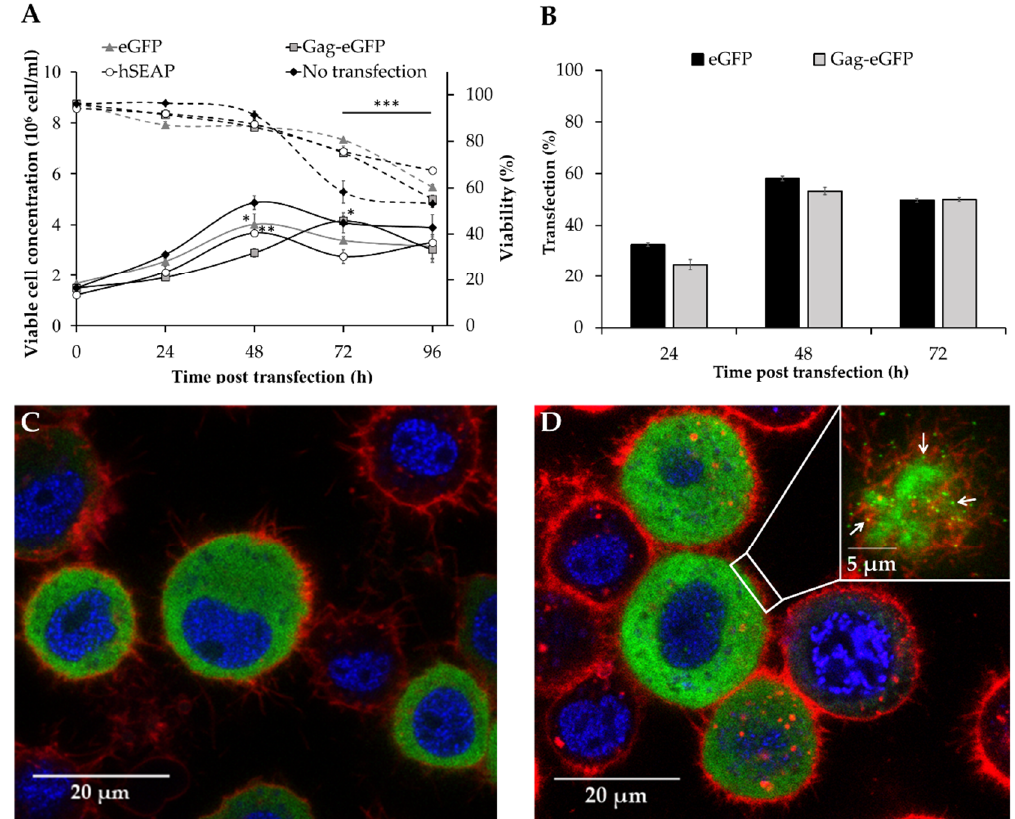
Figure 1. Transient gene expression of eGFP, hSEAP and HIV-1 Gag-eGFP VLPs in High Five cells cultured in shake flasks. ( A ) Cell growth (solid lines) and viability (dashed lines) profiles. ( B ) Transfection efficiencies measured by flow cytometry. ( C – D ) Fluorescence microscopy images of transfected High Five cells producing eGFP ( C ) and Gag-eGFP VLPs ( D ). Cell membranes were stained in red with CellMask TM and cell nucleus in blue with Hoechst 33342. VLPs can be observed as green dots (white arrows) budding from cells. Cell nucleus was stained with Hoechst 33342 (blue) and membrane was stained with CellMask TM (red). Mean values ± standard deviation of triplicate experiments are represented. A Dunnett’s test analysis was used to compare the peak of viable cell concentration of the different conditions with the control (no transfection), while a Student t -test was performed to evaluate the drop in cell viability between 72 and 96 hpt. * p -value < 0.05, ** p -value < 0.01, *** p -value < 0.001.